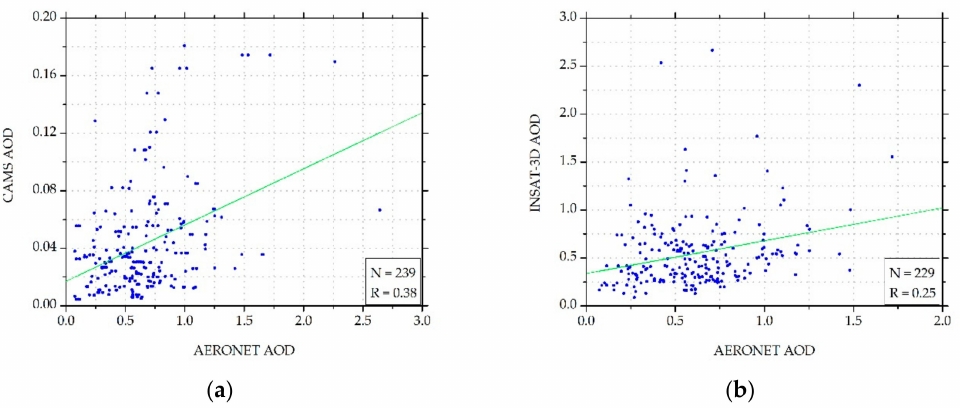
Figure 13. Scatterplots of ( a ) AOD forecasted by CAMS and ( b ) AOD derived from INSAT-3D, as compared to Aeronet AOD.